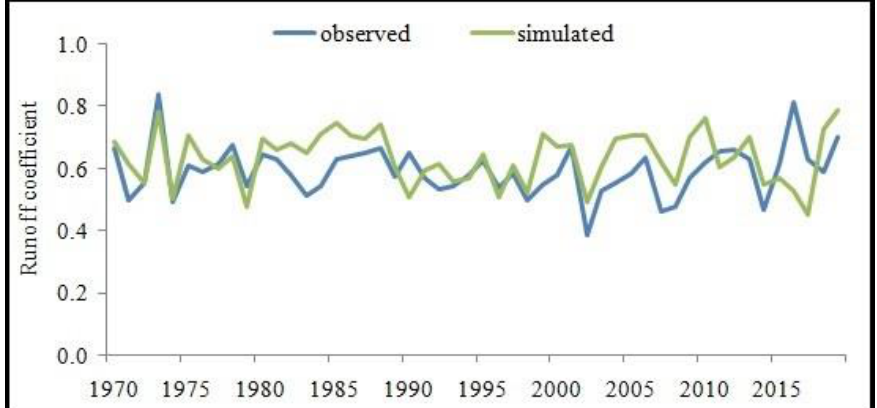
Figure 5. Interannual observed and simulated runoff coefficients of the Iya River at Tulun gauge over the period 1970–2019.